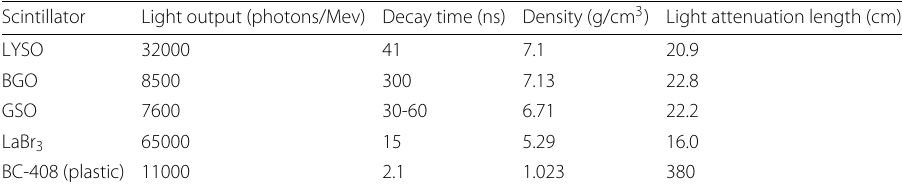
Table 4 Scintillators used in PET